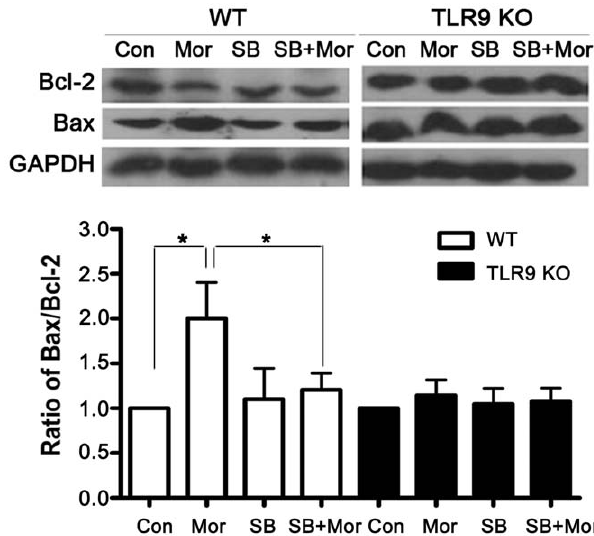
Figure 5. Blockade of p38 MAPK by SB203580 inhibits morphine-induced changes in Bcl-2 and Bax expression levels. WT microglia were exposed to SB203580 (SB) at 10 m M and then treated with morphine at 10 m M for 24 hr. The expression of Bax and Bcl-2 was examined by Western blot analysis. Representative results of the levels of Bcl-2 and Bax are shown of each pane. Mean values were derived from three independent experiments. * p , 0.01 compared with indicated